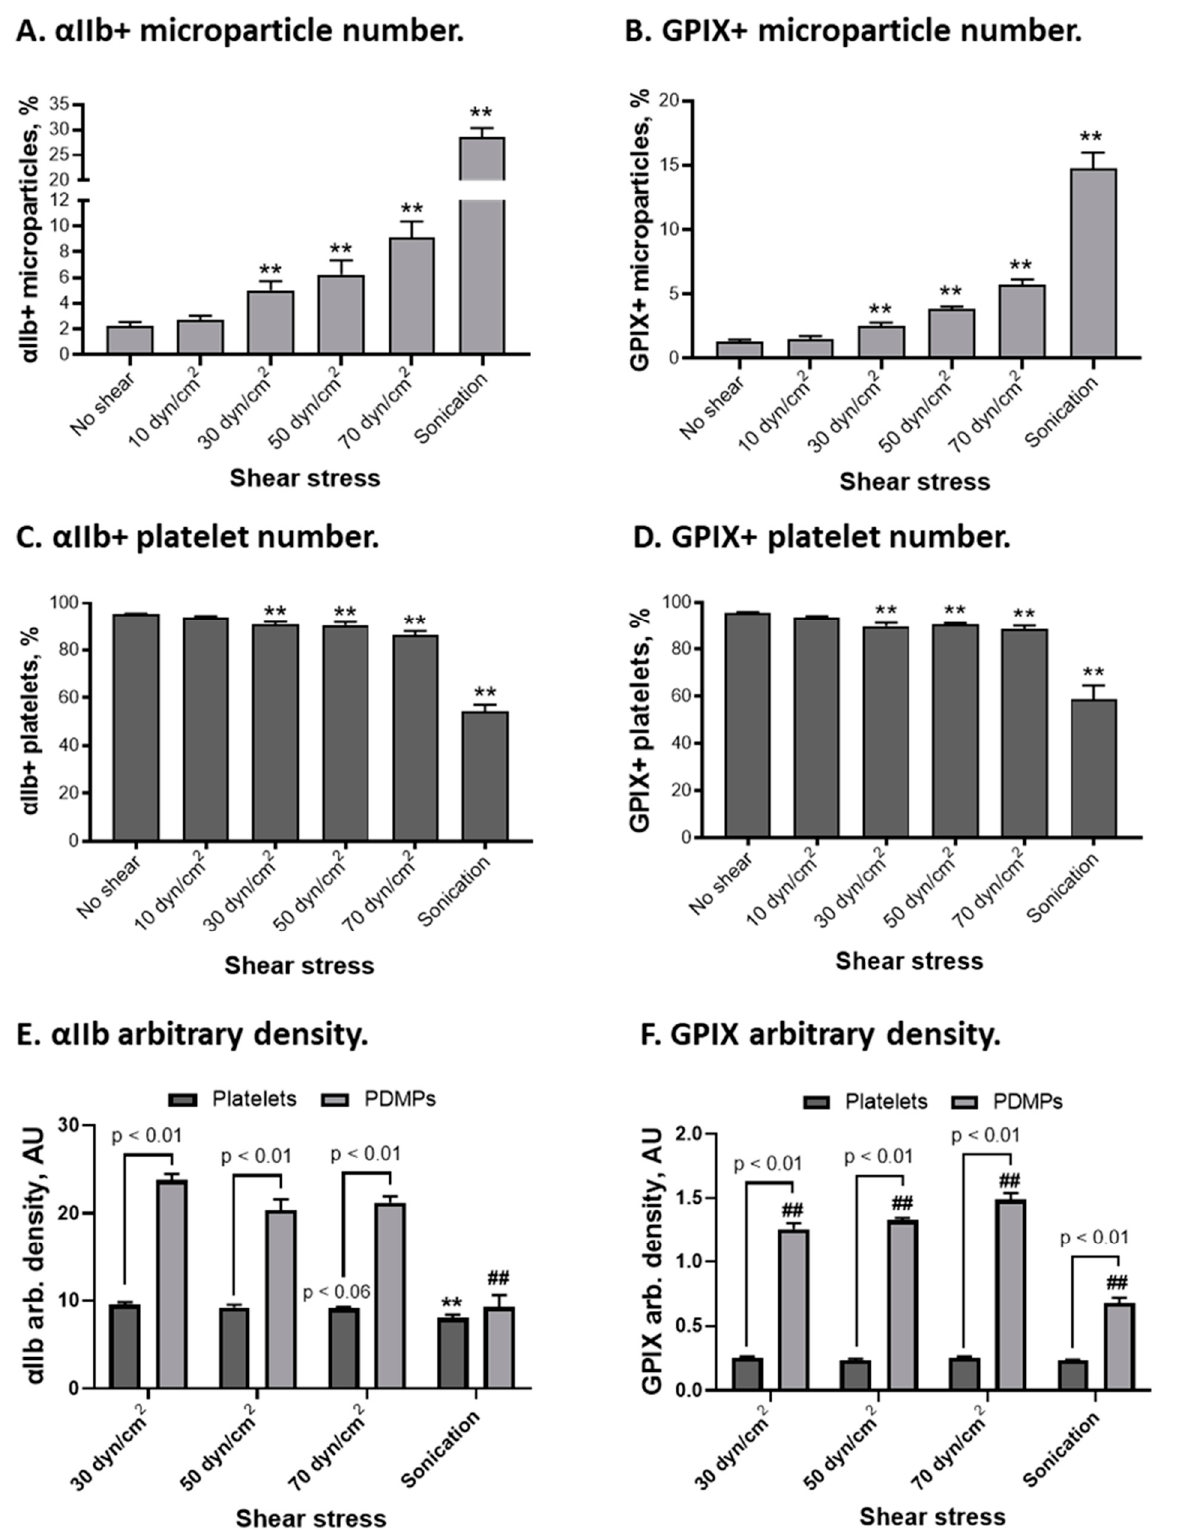
Figure 4. Distribution of α IIb β 3 integrin and GPIX on platelets and platelet-derived microparticles (PDMPs): ( A , B )— α IIb (CD41)+ and GPIX (CD42a)+ PDMP number, ( C , D )— α IIb (CD41)+ and GPIX (CD42a)+ platelet number, ( E , F )—arbitrary density of α IIb β 3 (CD41) and GPIX (CD42) on platelets and PDMPs. n = 4–6. Mean ± SEM, 1-way ANOVA followed by Dunnett multiple comparisons test: **, ##— p < 0.01 vs. no shear for platelets and